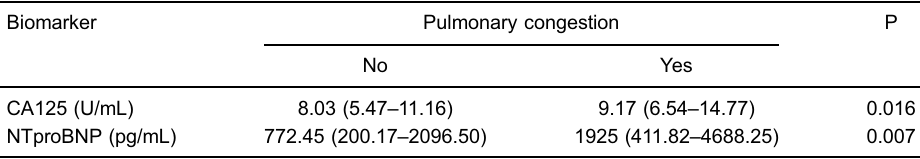
Table 2. CA125 and NTproBNP levels according to pulmonary